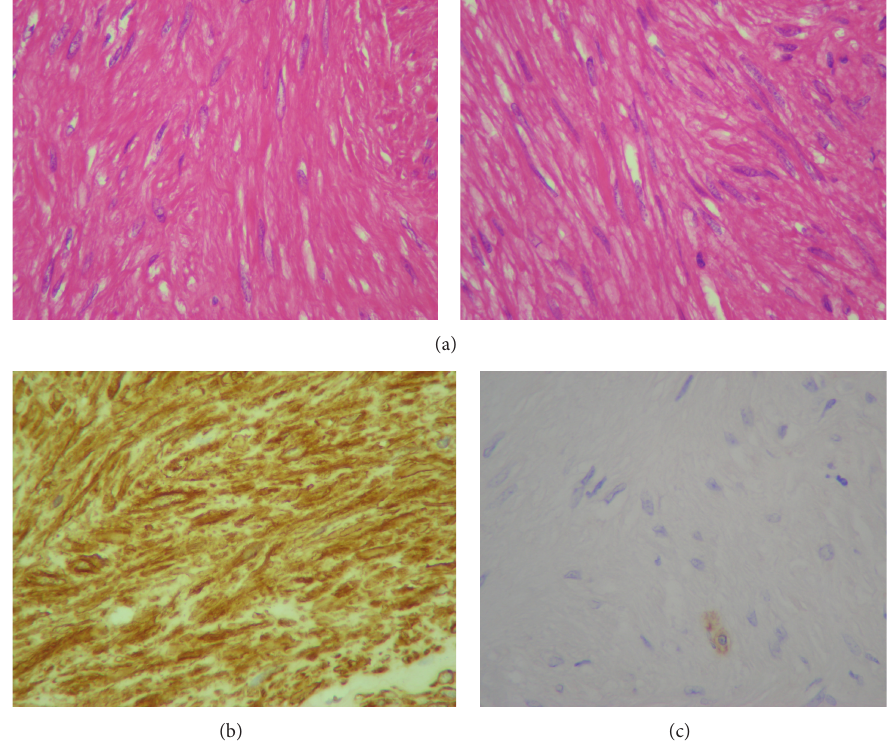
Figure 1: Histopathological images of the gastric leiomyoma analyzed. (a) Intersecting bundles of bland spindle cells in TC (left) and in TP (right). (b) Strong smooth muscle actin immunoreactivity. (c) Negative immunostain with CD117 (a positive mastocyte is shown as positive internal